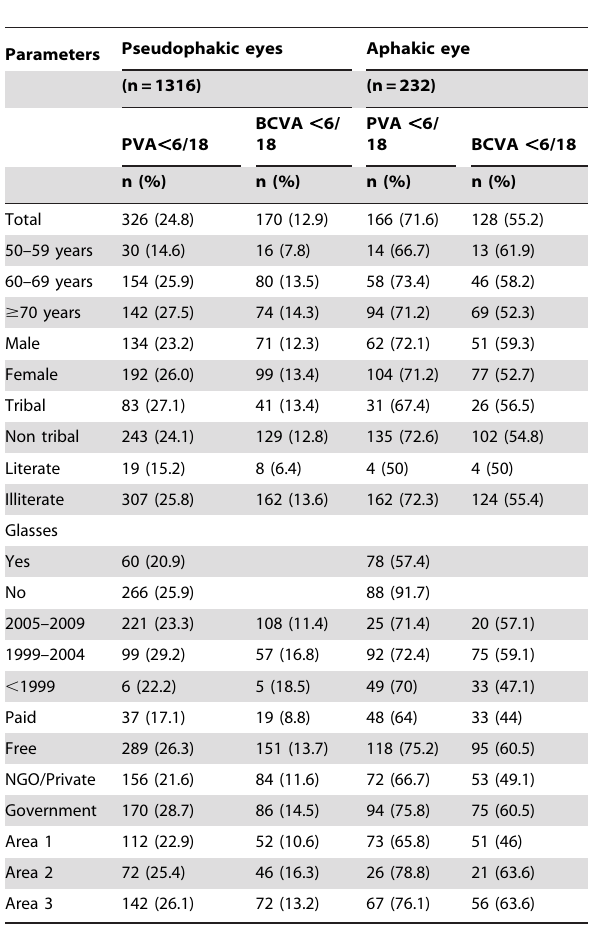
Table 2. Proportion of eyes with pseudophakia and aphakia having presenting and best corrected visual acuity , 6/18.